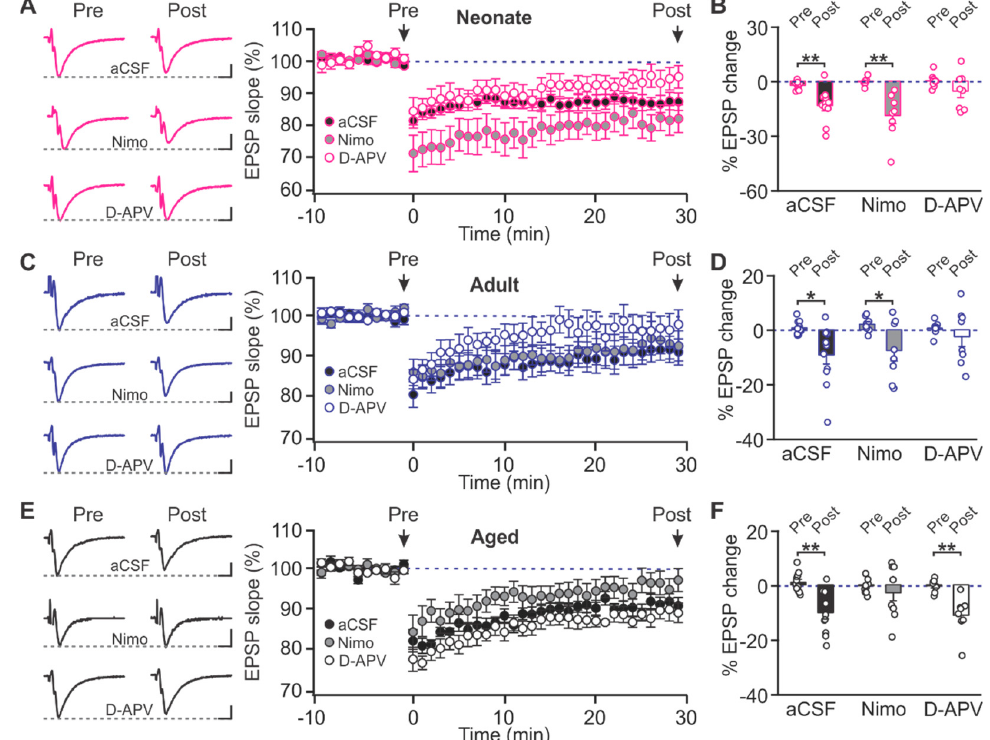
Figure 3. Age-dependent LTD compositions in the piriform cortex layer Ib . ( A , B ) Example traces and time courses of fEPSPs with LTD inductions in aCSF, nimodipine (Nimo) and D-APV ( A ), and % changes of fEPSPs at 30 min post-LTD induction ( B ) in neonate rats. aCSF: n = 11; nimo: n = 8, APV: n = 8. ( C , D ) Time courses with LTD inductions and % changes of fEPSPs in adult rats. aCSF: n = 11; nimo: n = 8, APV: n = 8. ( E , F ) Time courses with LTD inductions and % changes of fEPSPs in aged rats. aCSF: n =11; nimo: n =10, APV: n =8. Scale bars, 0.5 mV, 5 msec. * p < 0.05; ** p < 0.01.